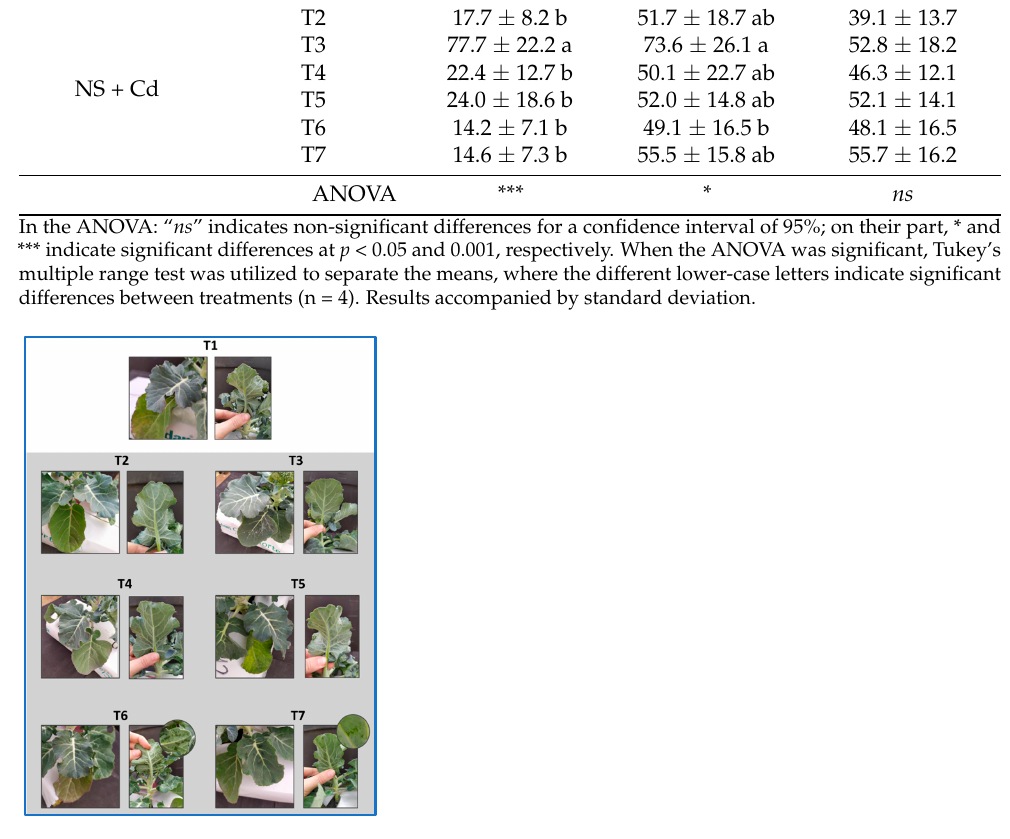
Figure 3. Toxicity symptoms in broccoli plants grown under Cd toxicity conditions and treated with different active materials to mitigate this toxicity (T1: NS, T2: NS + Cd, T3: NS + Cd + BioG, T4: